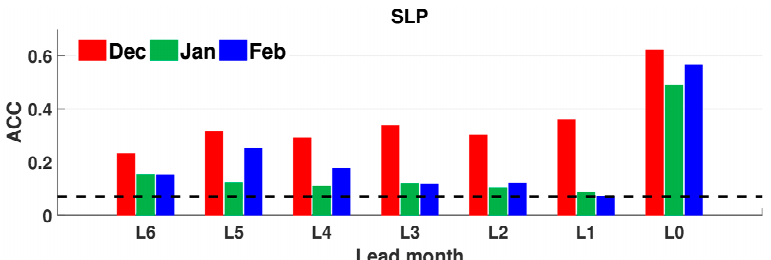
Figure 5. The spatial anomaly correlation coefficient (ACC) between the observed and CFSv2-predicted sea level pressure (SLP) monthly differences at 6- to 1-month leads in the North Atlantic (20°–80° N, 90° W–40° E). The black lines indicate statistical significance at the 99% confidence level, as estimated by a local Student’s t -test.